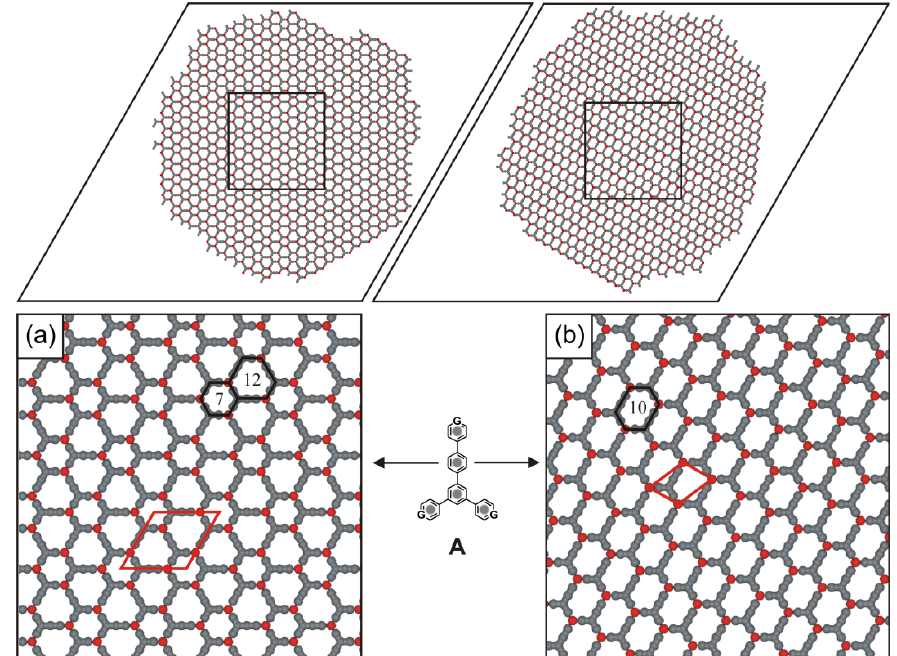
Figure 2. ( a ) The open porous metal–organic network composed of 600 metal atoms (red isolated segments) and 600 achiral ligands A in optimal 1:1 stoichiometric ratio at surface coverage θ ∼ 0.21, T = 0.001; ( b ) homogenous brick wall-like overlayer comprising 600 metal atoms and 600 molecules A at surface coverage θ ∼ 0.21, T = 0.001. In the magnified fragments of the corresponding phases, the rhombic unit cells are marked (solid red lines). The solid black lines mark the edges of empty pores differing in size and shape. Inside the highlighted nanopores, the numbers of empty adsorption sites are given. The vertices of a triangular lattice (adsorption sites) are not shown for the sake of clarity.